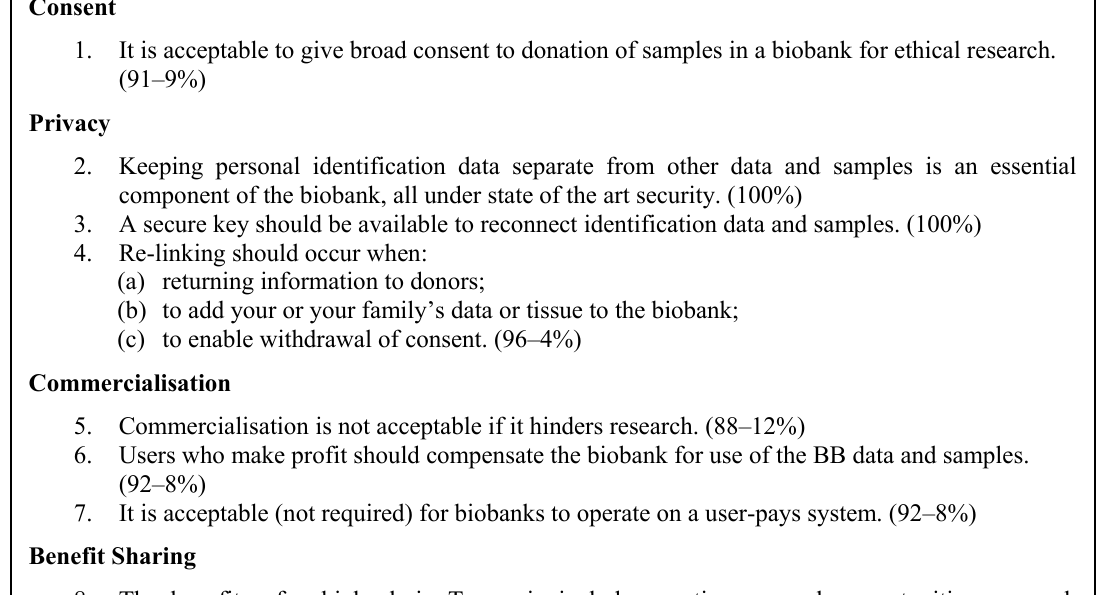
Figure 2. Participant outcomes with large group ratification results